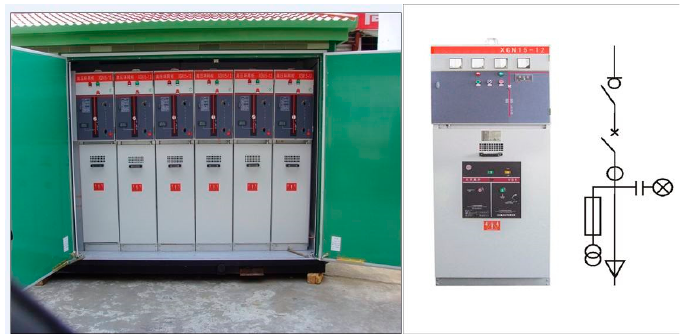
Figure 1. Ring network cabinet structure diagram (left is a physical image, and right is a function diagram).